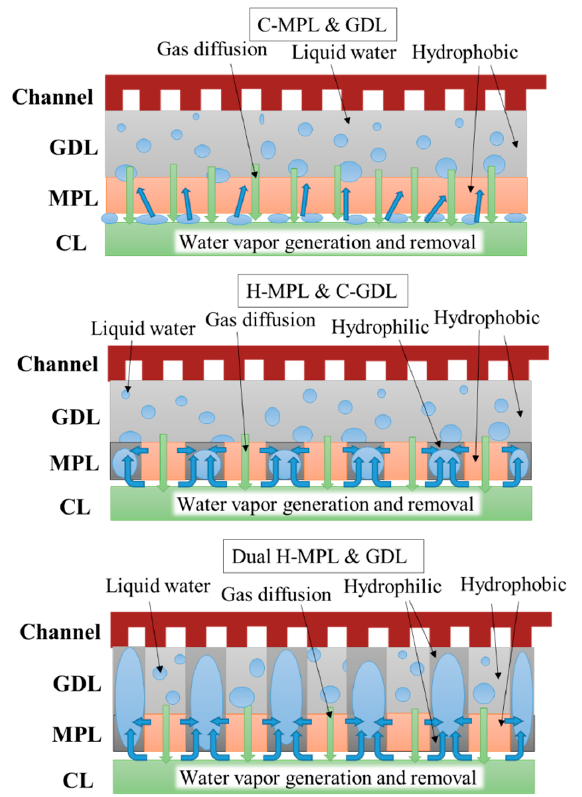
Figure 10. Predicted sketch of liquid water distribution in PEMFC with different MPL/GDL